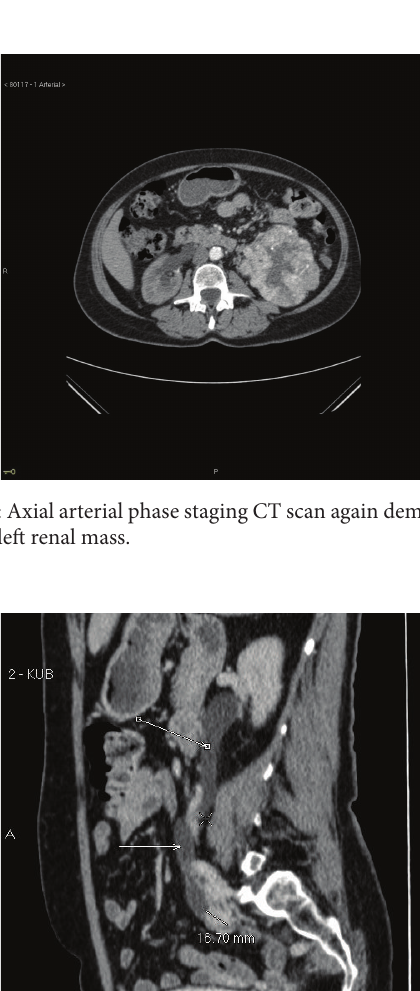
Figure 1: Axial portal venous phase CT scan at initial presentation demonstrating a 56 mm mass of the interpolar left kidney. Normal left renal vein.